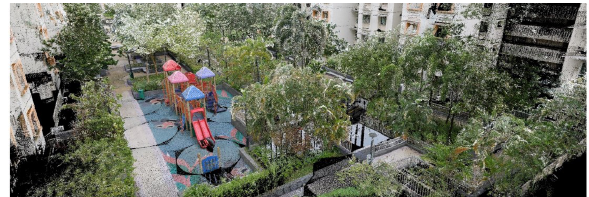
Figure 12. Example outputs of one of the rooftop gardens scanned using the Riegl VZ-400i.